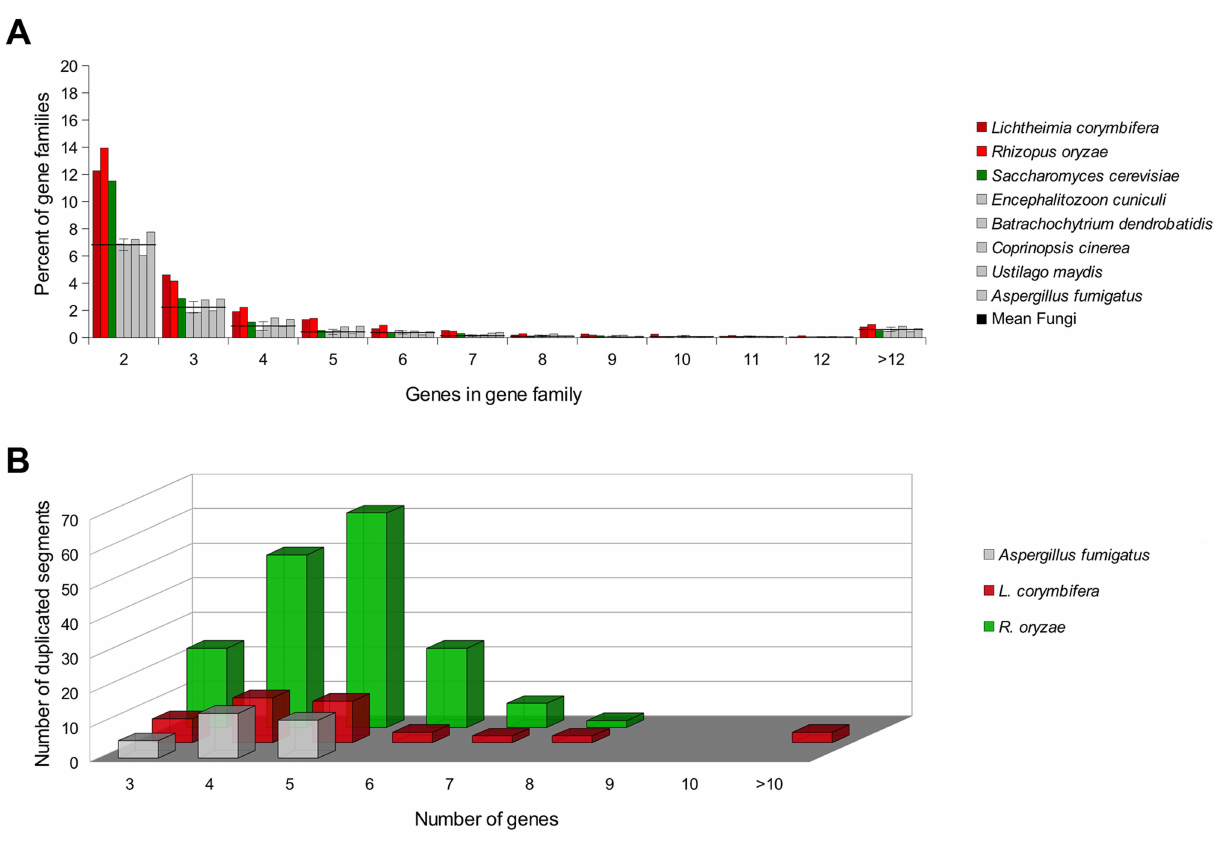
Figure 3. Gene duplication and duplication of genomic regions within mucoralean genomes in comparison to the genome of A. fumigatus , which (i) inhabits the same natural habitats and (ii) causes similar symptomatology in human like L.corymbifera and (iii) serves as model organism for causative agents of invasive mycoses [ 56,75 ] . The genome of A. fumigatus serves as measure for low incidences of singular and segmental gene duplications [115,116]. (A) Comparison of gene families between L. corymbifera , R. oryzae and non- mucoralean fungi. Gene families are based on GhostFam homology families. Values for L. corymbifera and R. oryzae are excluded from the ‘‘mean fungi’’ value. (B) Regions with a minimum of 3 genes were tested for multiple occurrences within the genomes by GECKO2.